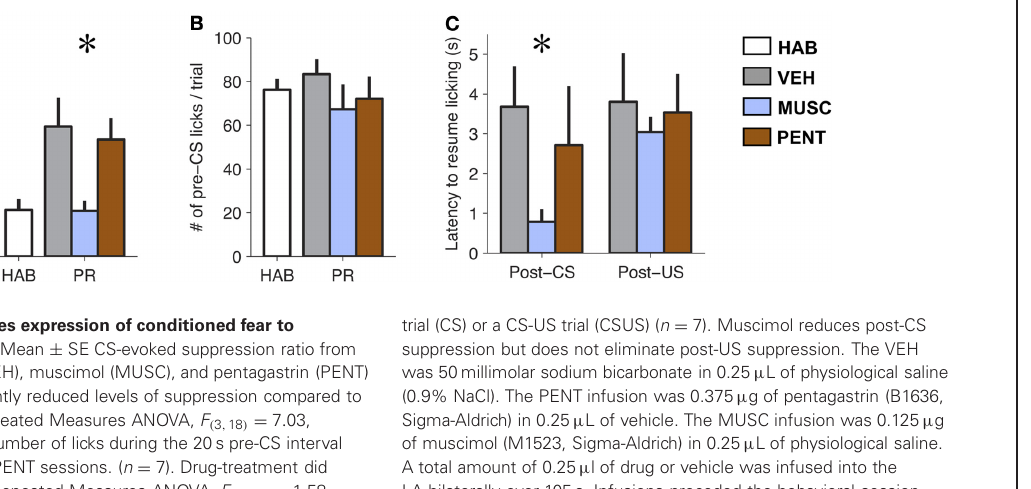
trial (CS) or a CS-US trial (CSUS) ( n = 7). Muscimol reduces post-CS suppression but does not eliminate post-US suppression. The